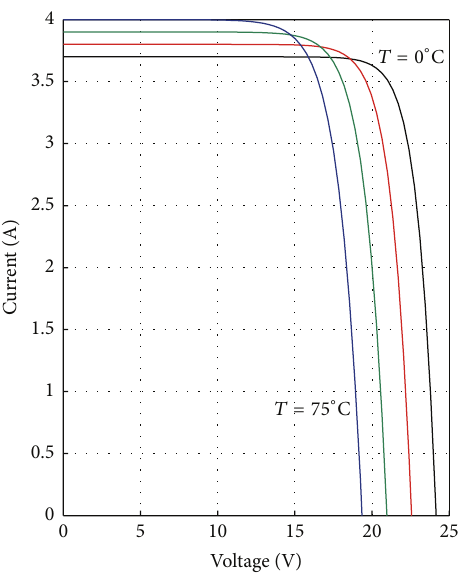
Figure 5: MATLAB model 𝐼 - 𝑉 curves for various temperatures.